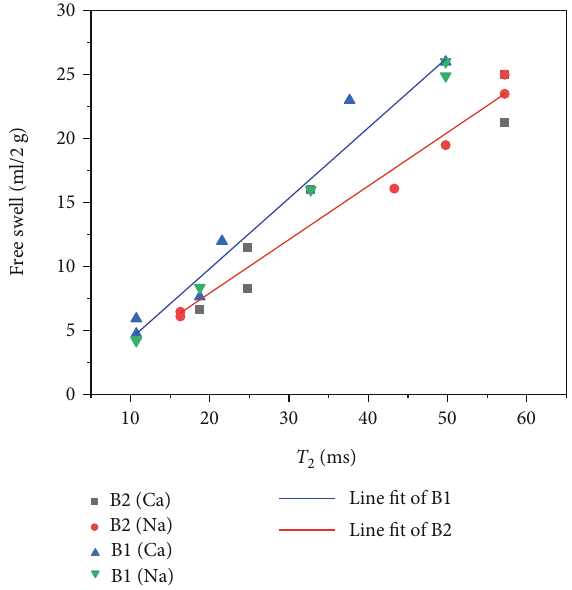
Figure 10: Free swell as a function of optimum T